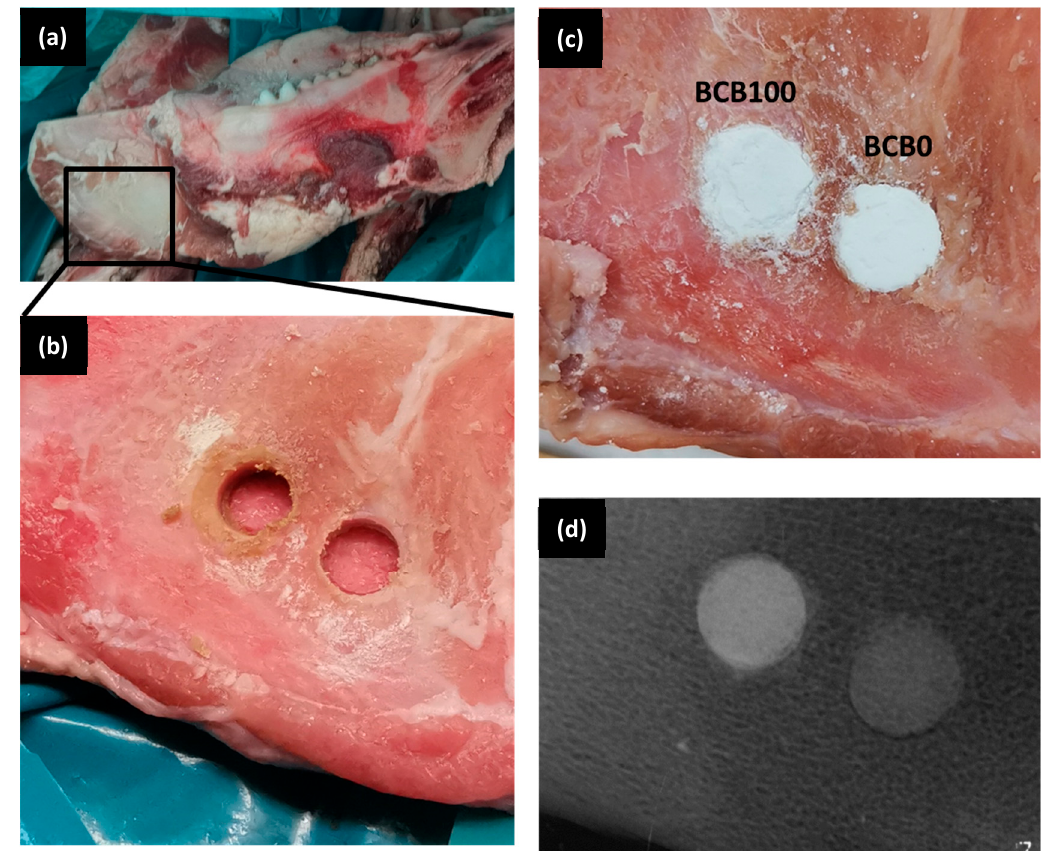
Figure 6. ( a ) Photographs of porcine cadaver mandible with ( b ) 6 × 3.5 mm bore holes generated with a trepan drill, and ( c ) filled with either BC (BCB0) or BCB100 cement. ( d ) An X-ray image of the cement implants demonstrates an improved visibility due to the higher radiopacity of the BCB100 cement.